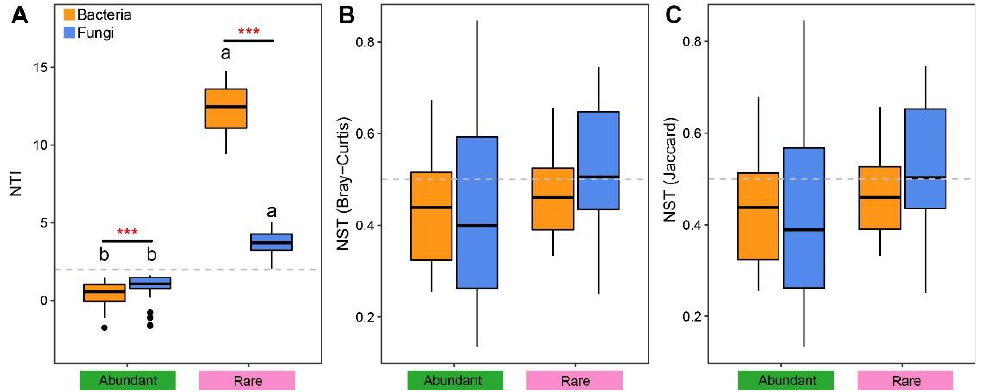
Figure 4. The nearest taxon index (NTI) ( A ) and normalized stochasticity ratio (NST) based on Bray – Curtis distance ( B ) and Jaccard distance ( C ) of abundant and rare rhizosphere bacterial and fungal subcommunity. Different letters above bars and *** indicate a significant difference at the p < 0.05 and 0.001 level according to nonparametric Mann – Whitney U test.